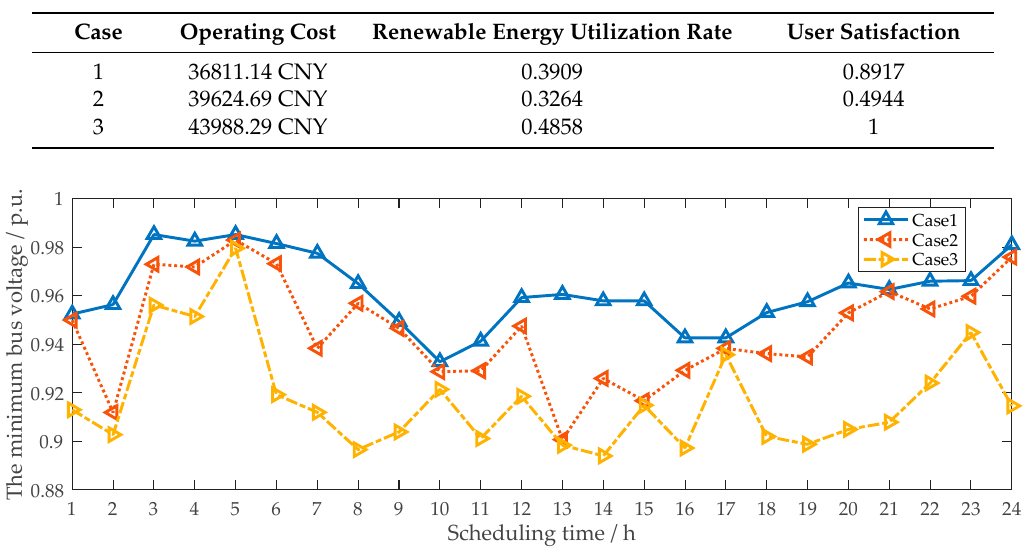
Figure 13. Comparison of minimum bus voltage in a day.